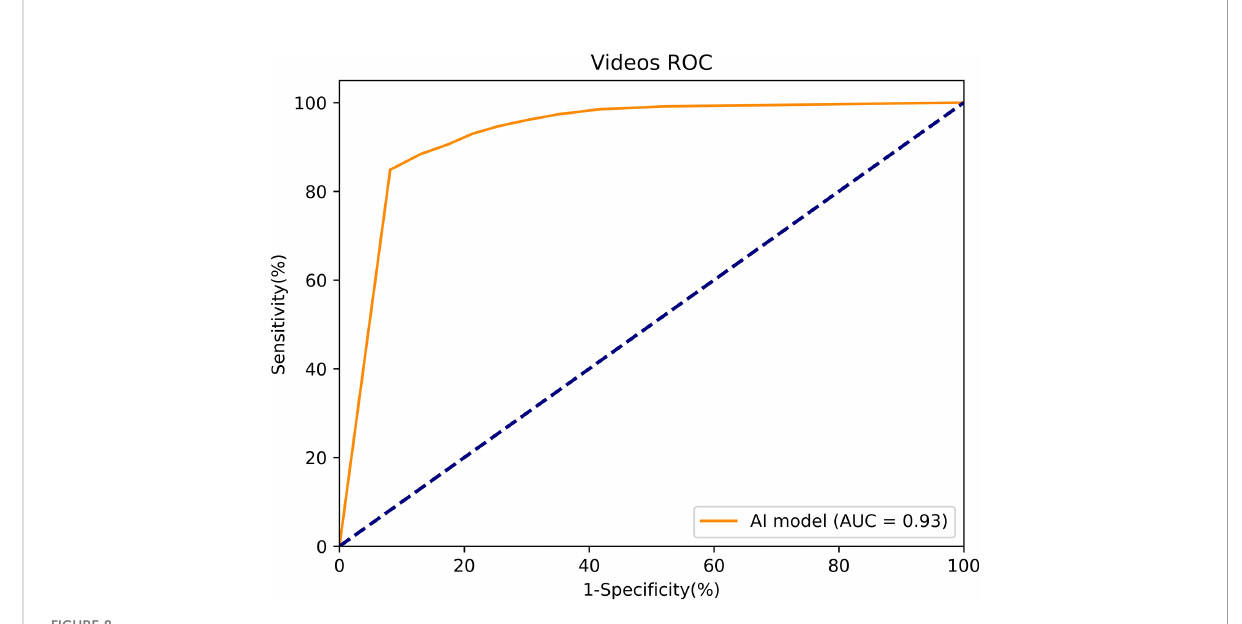
FIGURE 8 The ROC curve of the white light real-time videos